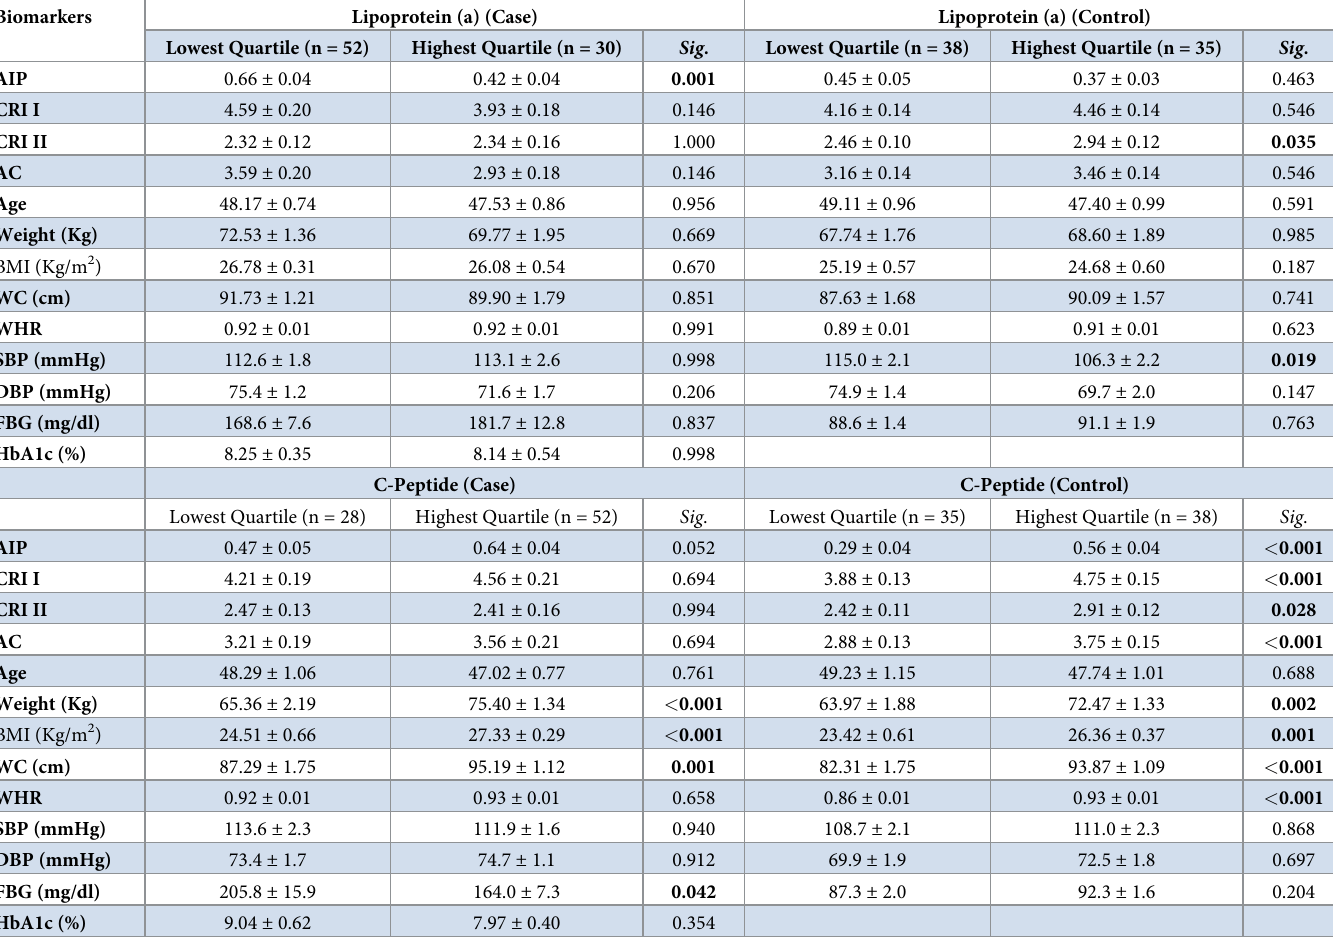
Table 3. Mean ± SE � of atherogenic indices¶ and cardiometabolic biomarkers‡ of plasma according to lowest and highest quartiles of lipoprotein (a) and C-Peptide levels. Biomarkers